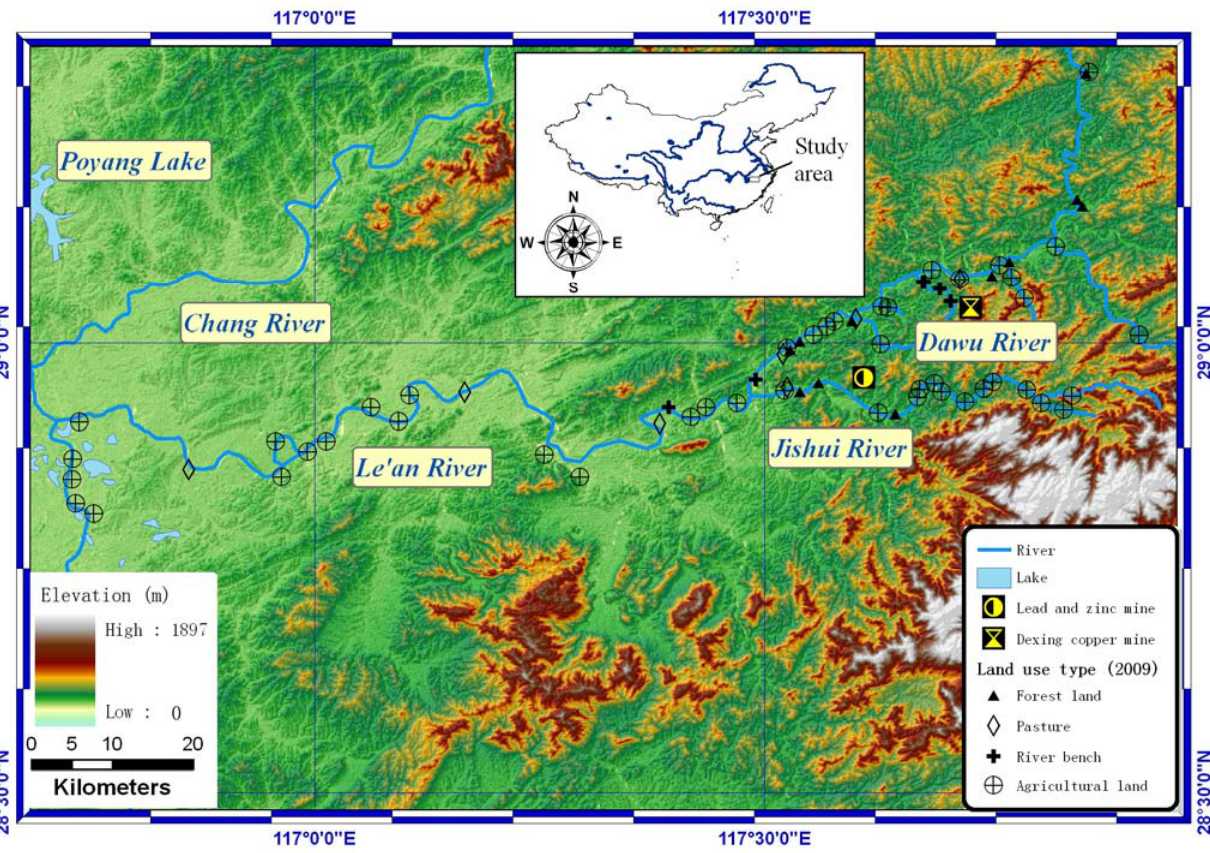
Figure 1. Map showing Poyang Lake, Le’an River, Jishui River, Dawu River, Yishan lead- zinc mine, Dexing copper mine, sampling sites and elevation of the study